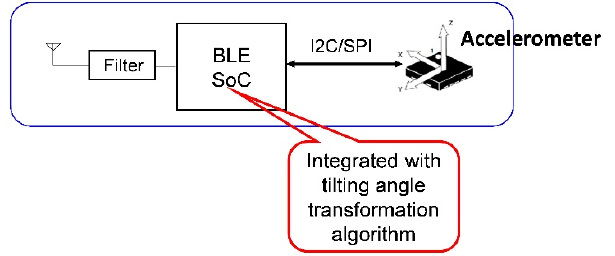
Figure 2. Architecture of the BASIC module.